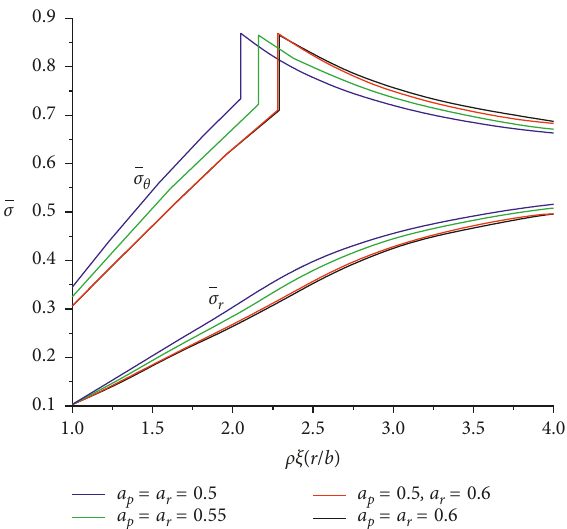
Figure 25: Distribution of radial and circumferential stresses for different values of a for the generalized H-B rock mass.